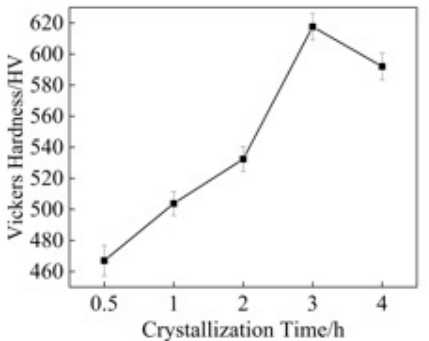
Figure 15. Effects of crystallization time on the Vickers hardness of the microcrystalline glass